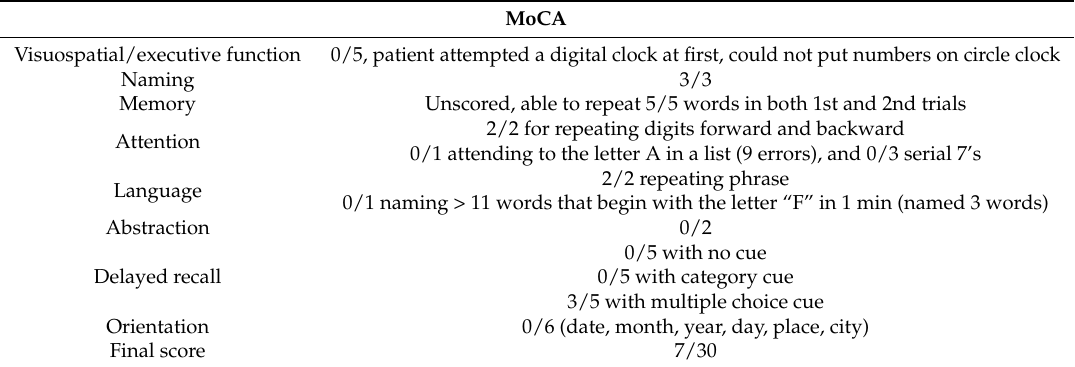
Table 1. Patient Montreal Cognitive Assessment (MoCA) test assessment result of 7/30 with good effort.